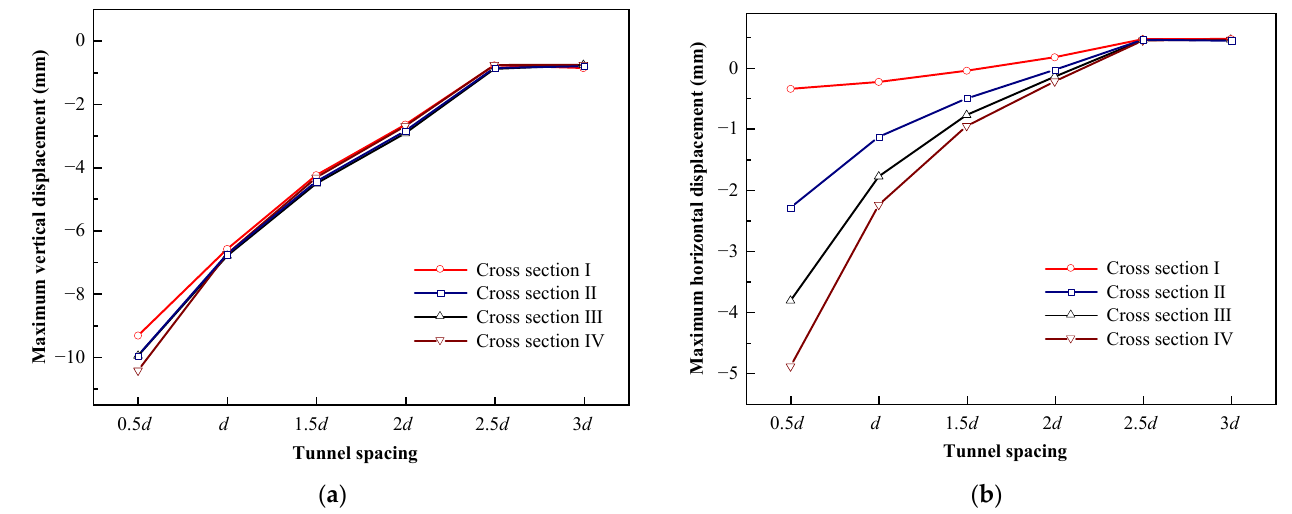
Figure 13. Relationship between tunnel spacing and displacements. ( a ) Maximum vertical displace- ment of vault; ( b ) maximum horizontal displacement of adjacent side wall.